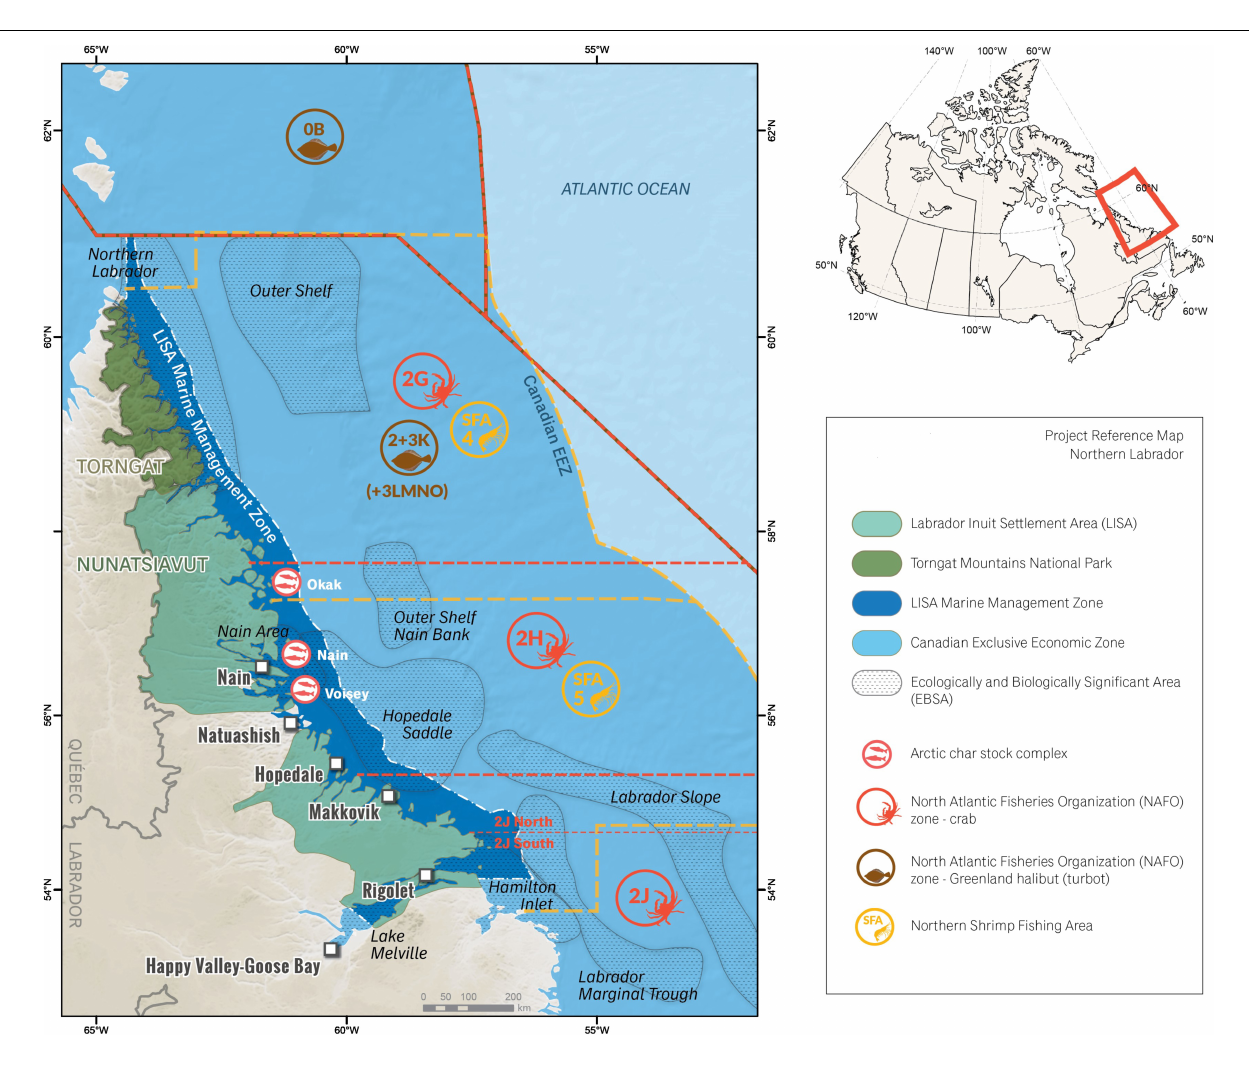
FIGURE 1 | Nunatsiavut, commercial fisheries, and management